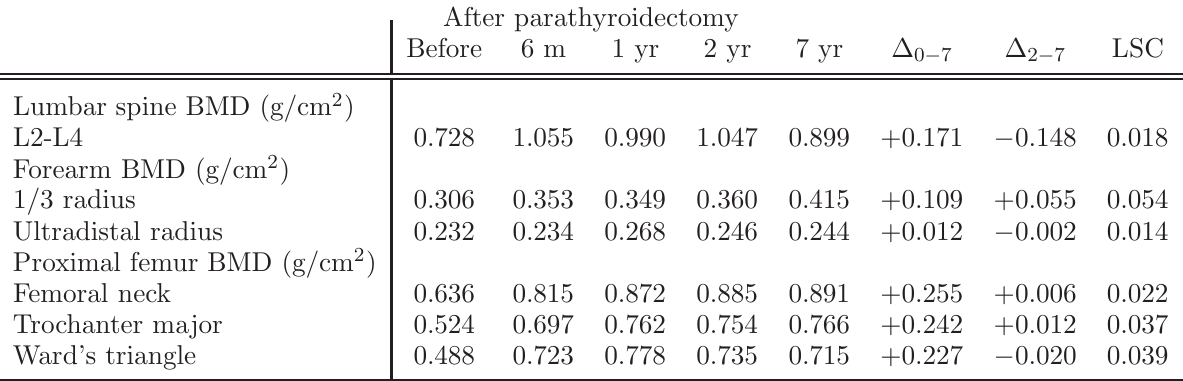
Table 2 Results of QUS measurements in patient with primary hyperparathyroidism before and after parathyroid adenoma surgery. Presentation of the differences between values according to least significant change